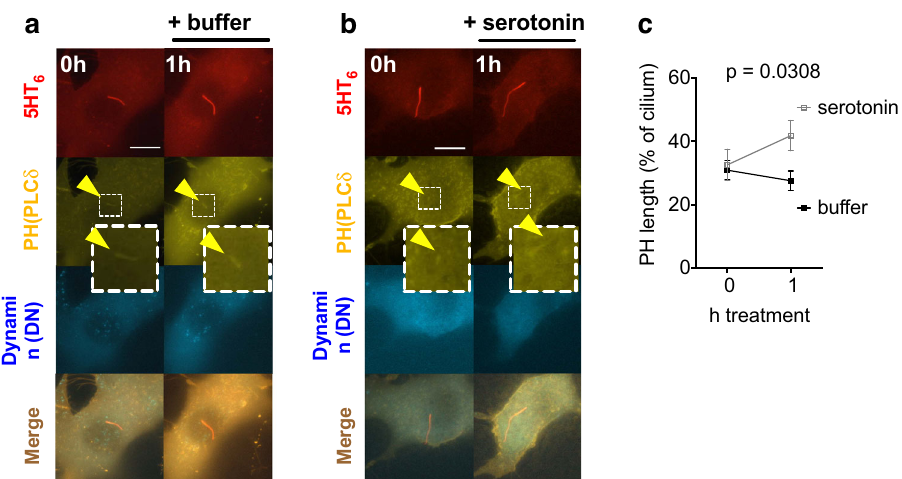
Fig. 5 Activation of ciliary 5HT 6 receptor leads to an increase in ciliary PIP 2 . a , b Time-lapse images of NIH3T3 cells expressing the ciliary marker 5HT 6 - mCherry, CFP-tagged DN Dynamin2 to inhibit 5HT 6 endocytosis and the PIP 2 biosensor YFP-PH(PLC δ 1). Images were acquired before and 1 h after adding buffer ( a ) or serotonin (10 µ M fi nal, b ). Scale bar 10 µ m. c Length of PIP 2 as reported by PH(PLC δ 1) expressed relative to the cilium length in n = 21 cells treated as in ( a ) and n = 33 cells treated as in ( b ), two-way indicate that ciliary actin, AurkA and HDAC6 are required for the phenotype resulting from increased ciliary PIP 2 .